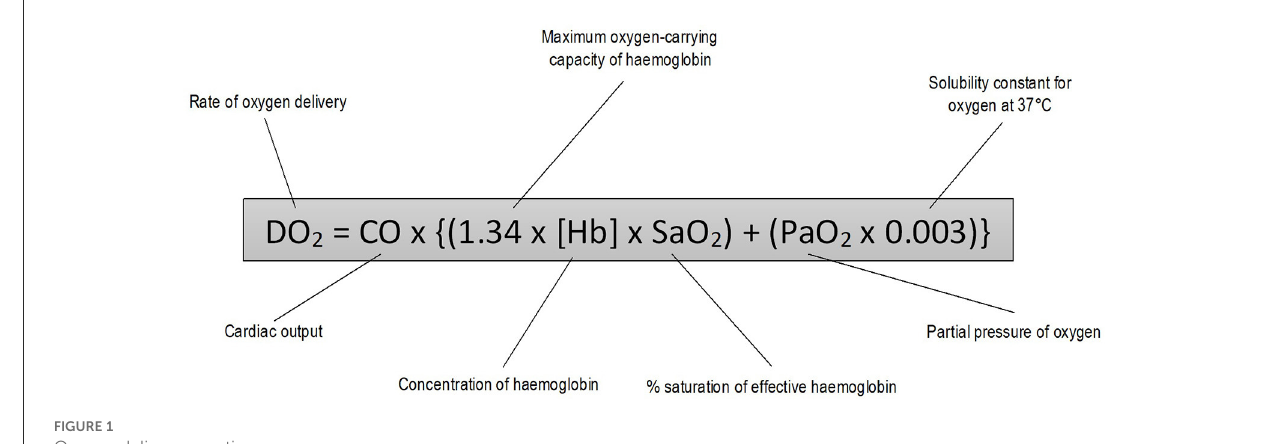
FIGURE1 Oxygen delivery